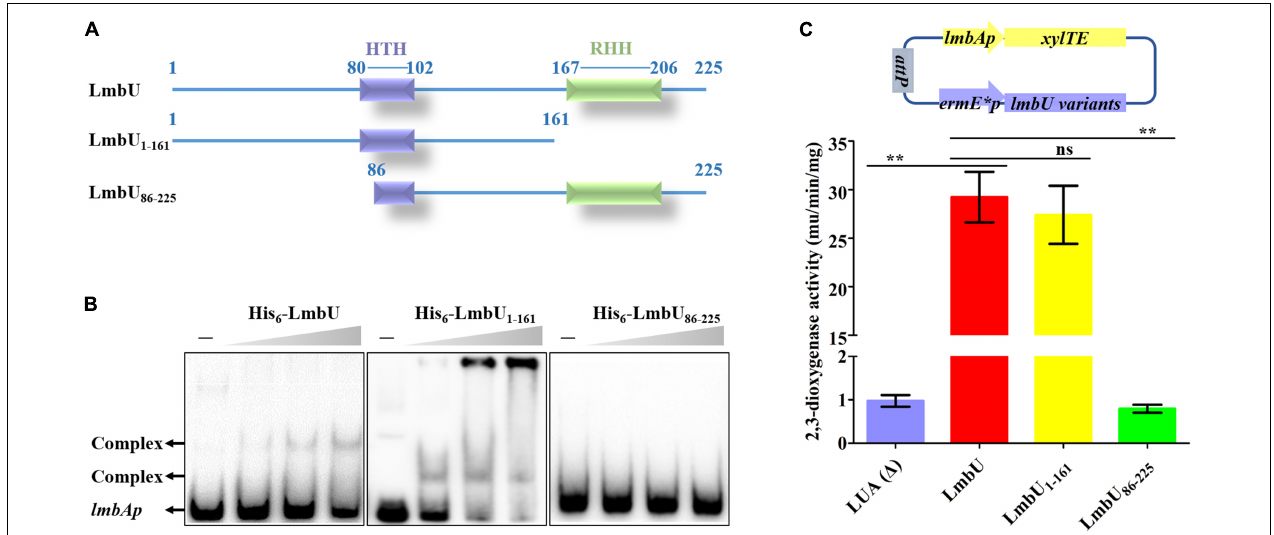
FIGURE 2 | Functional analysis of LmbU variants LmbU 1 - 161 and LmbU 86 - 225 . (A) Sketch map of LmbU protein and LmbU variants showing the location of the HTH (aa 80–102) and RHH motif (aa 167–206). (B) EMSA analysis of LmbU and variants with lmbAp probe. Biotin-labeled lmbAp (263 bp, 5 ng) was incubated with increasing concentrations (0, 3.2, 6.4, and 12.8 µ M) of His 6 -LmbU, His 6 -LmbU 1 - 161 , and His 6 -LmbU 86 - 225 , respectively. The DNA-protein complexes and the free probes are indicated by arrows. (C) XylTE reporter assay of LmbU and variants to lmbAp in vivo . The reporter plasmids were constructed with xylTE reporter gene controlled by lmbAp and lmbU or lmbU variants controlled by ermE ∗ p . The reporter plasmids were integrated into the attB site of the chromosome of JLUa2 to generate reporter strains. In addition, LUA was used as a negative control, which was derived from JLUa2 harboring xylTE reporter gene controlled by lmbAp . Data represent means ± standard deviations of results from three independent experiments. Statistical significance is indicated vs. the results of wild-type LmbU by using T test (Kim, 2015), ns, not significant, ∗∗ P <